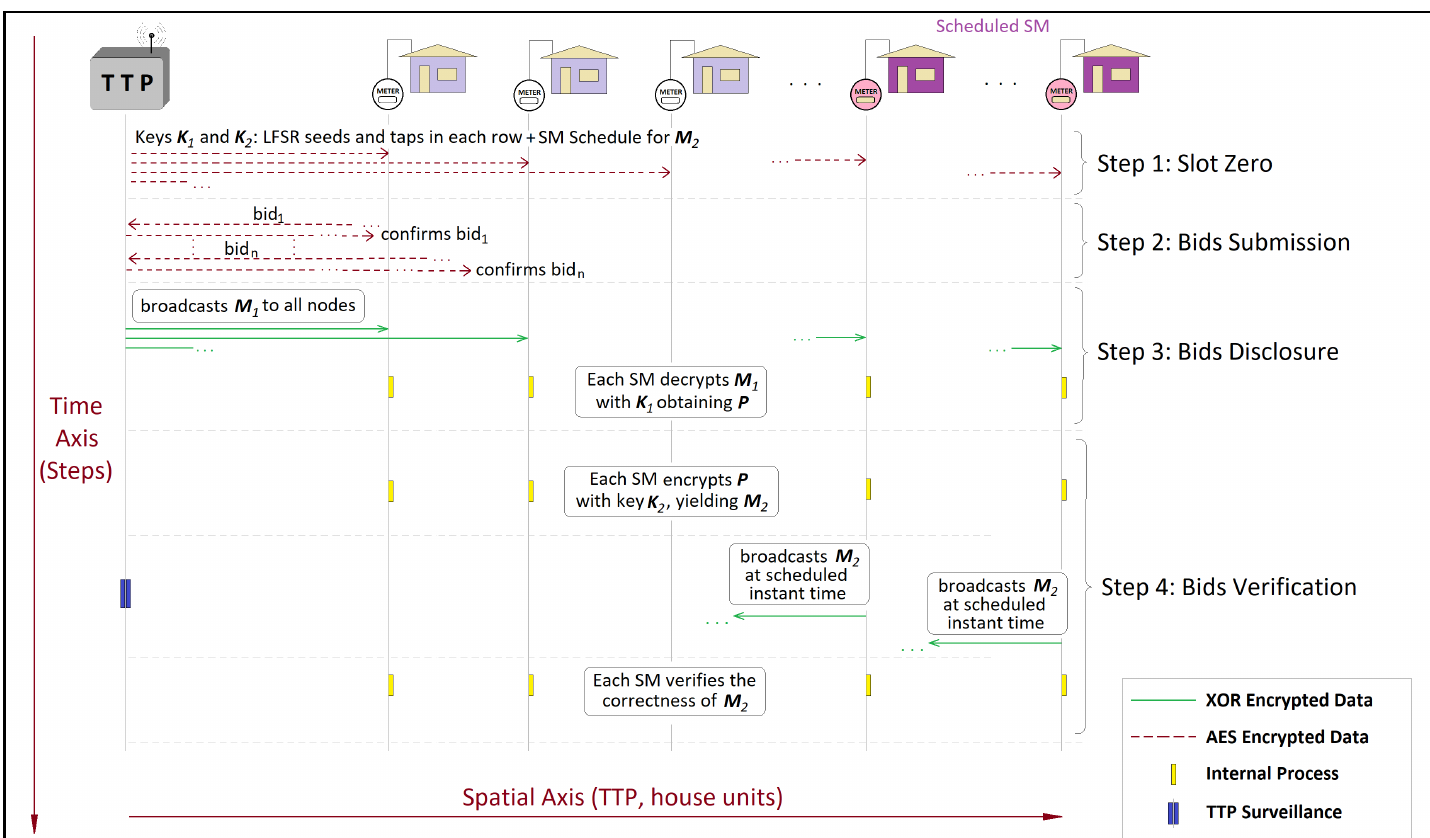
Figure 1. Overall sequence of steps in the proposed framework, with the slot zero and the stages of bids submission, bids disclosure, and bids verification: Note that, only in the slot zero and in the bids submission stage, the ciphertext is obtained via AES. The nodes designed to act as confirmation agents in a given time slot are depicted on the right side of the